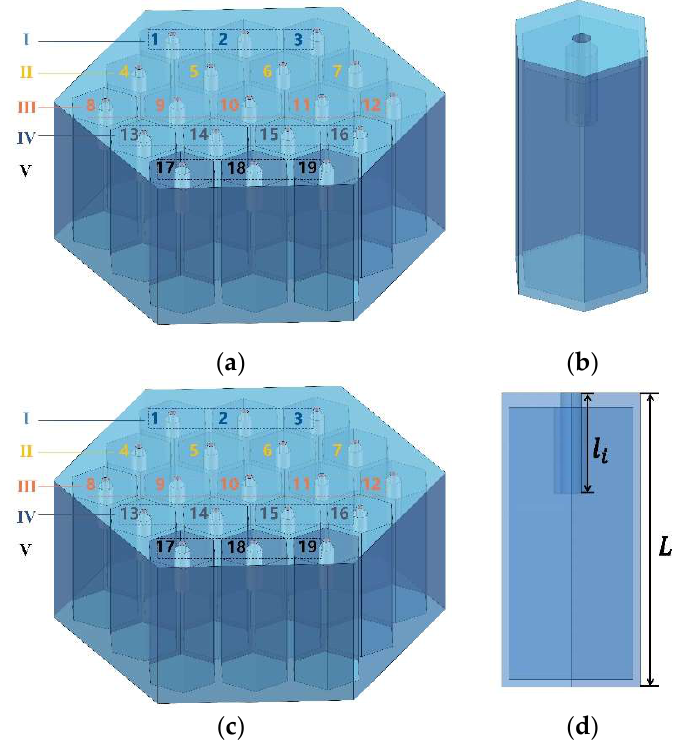
Figure 1. The designed acoustic metamaterial of multiple parallel hexagonal Helmholtz resonators. ( a ) Schematic diagram of the whole structure; ( b ) Structure of a single hexagonal Helmholtz resonator; ( c ) Top view of the single hexagonal Helmholtz resonator; ( d ) Main view of the single hexagonal Helmholtz resonator.